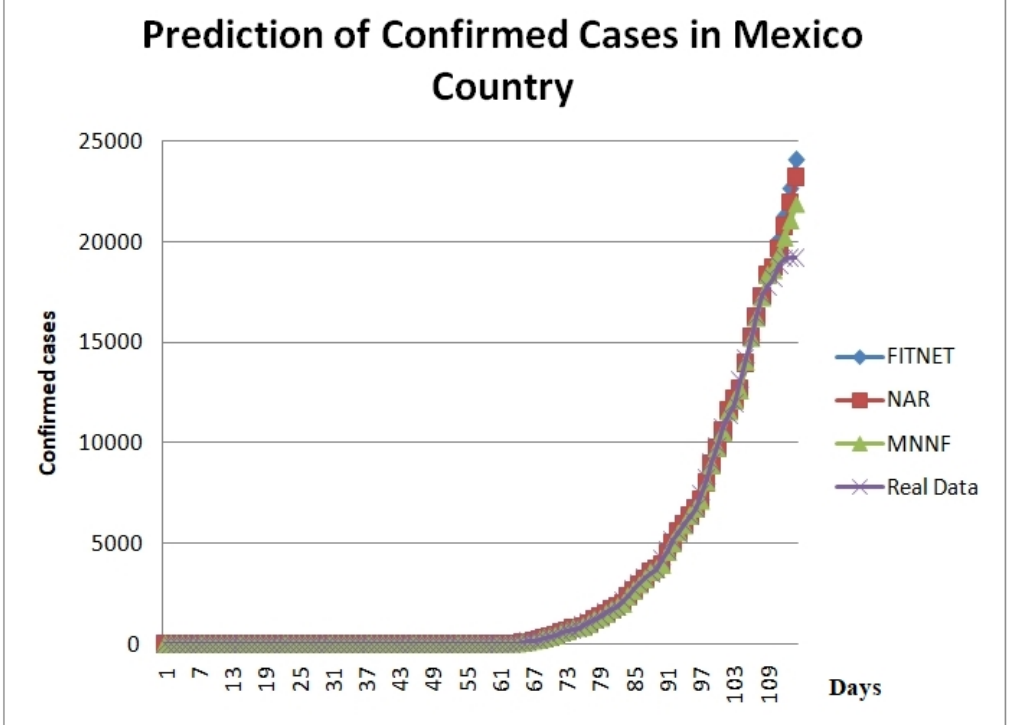
Figure 7. Comparison of the results of confirmed cases predicted in Mexico using different neural network models. Table 1. Comparison of predicted values for confirmed cases of Covid-19.